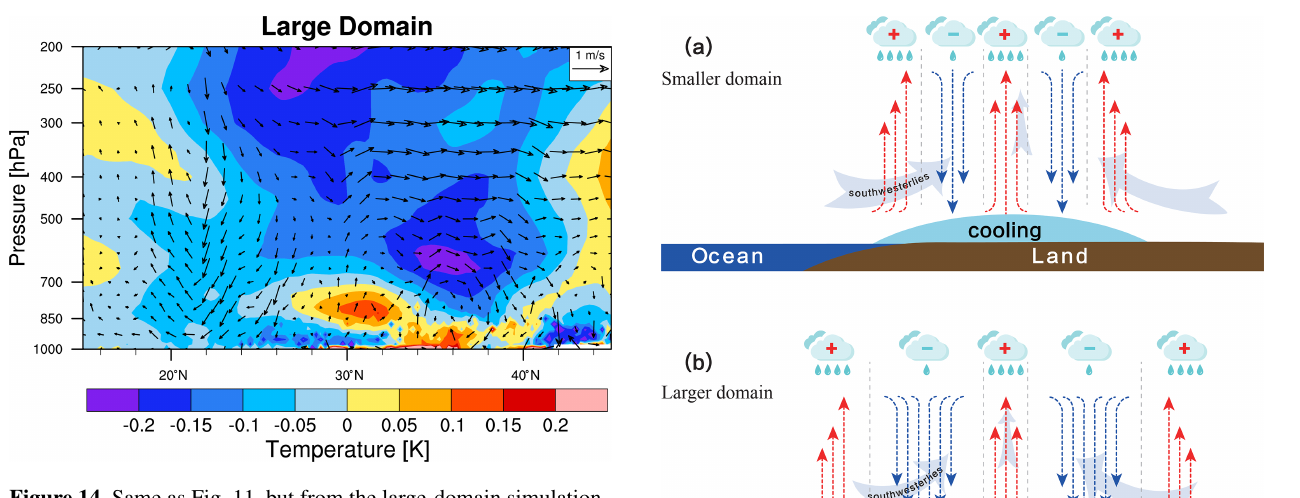
Figure 14. Same as Fig. 11, but from the large-domain simulation.